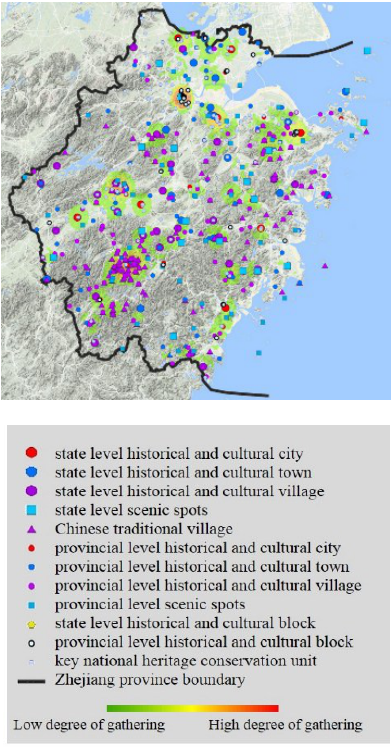
Figure 2.Distribution and Density Map of Cultural